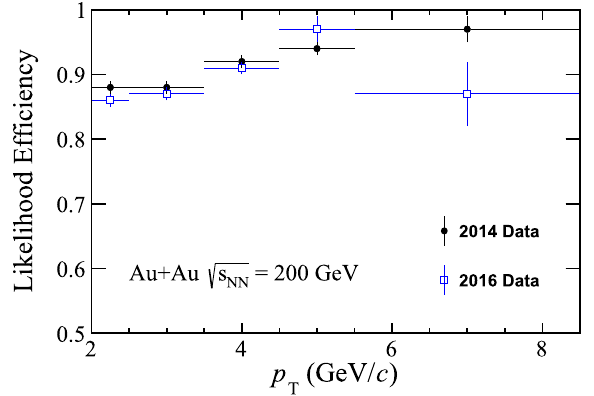
Fig. 3 The likelihood selection efficiency for 2014 (black circles) and 2016 (open blue squares) data